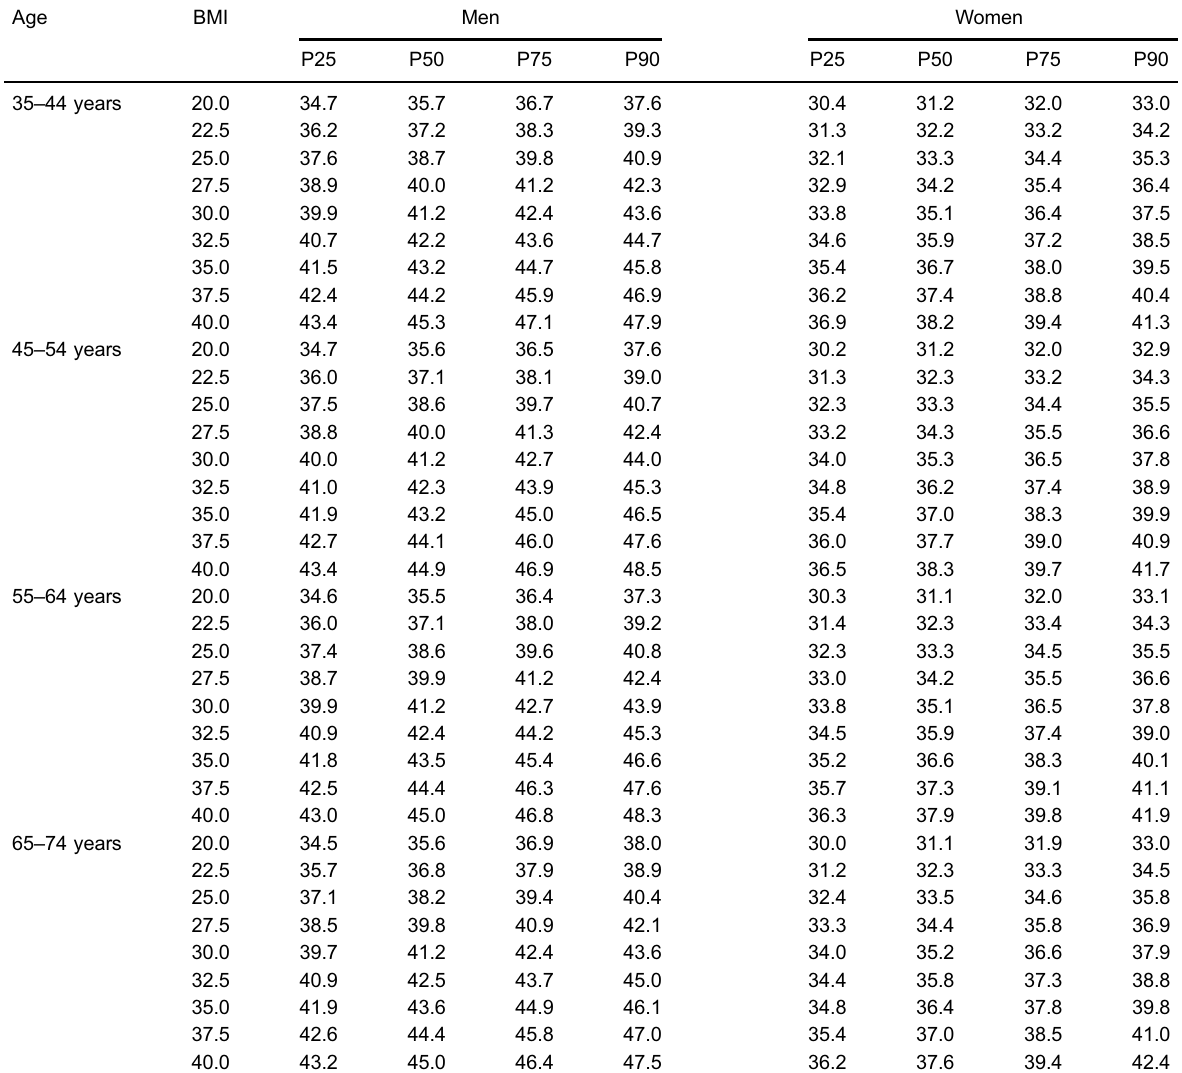
Table 2. Neck circumference predicted quantiles for sex, age, and body mass index (BMI). Age BMI